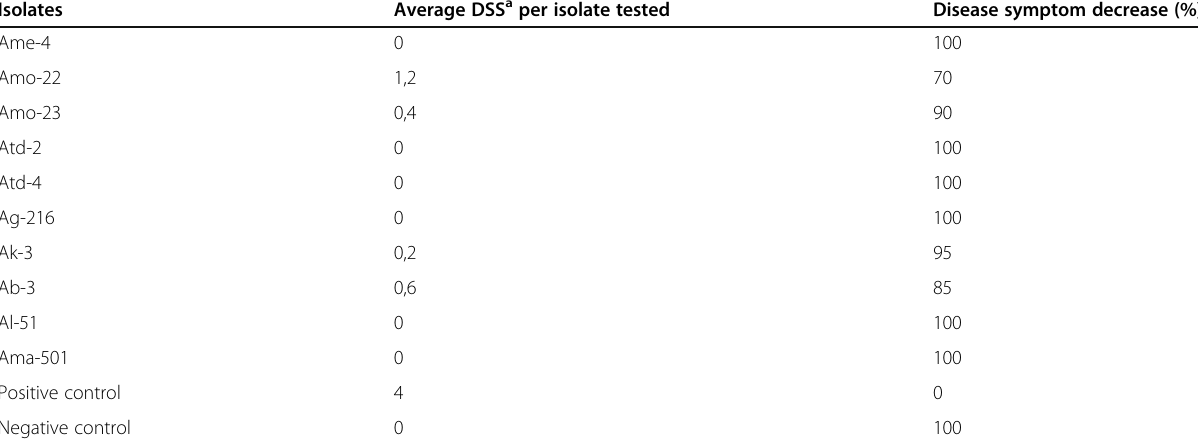
Table 1 Variation in disease symptoms score (DSS) of inoculated potato plants Isolates